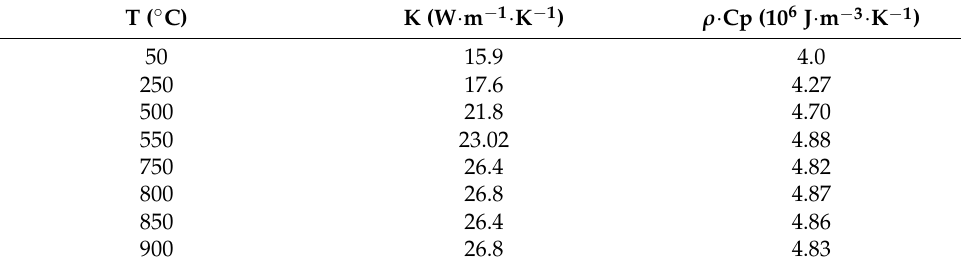
Table 2. Thermophysical properties of 304 L stainless steel [28].